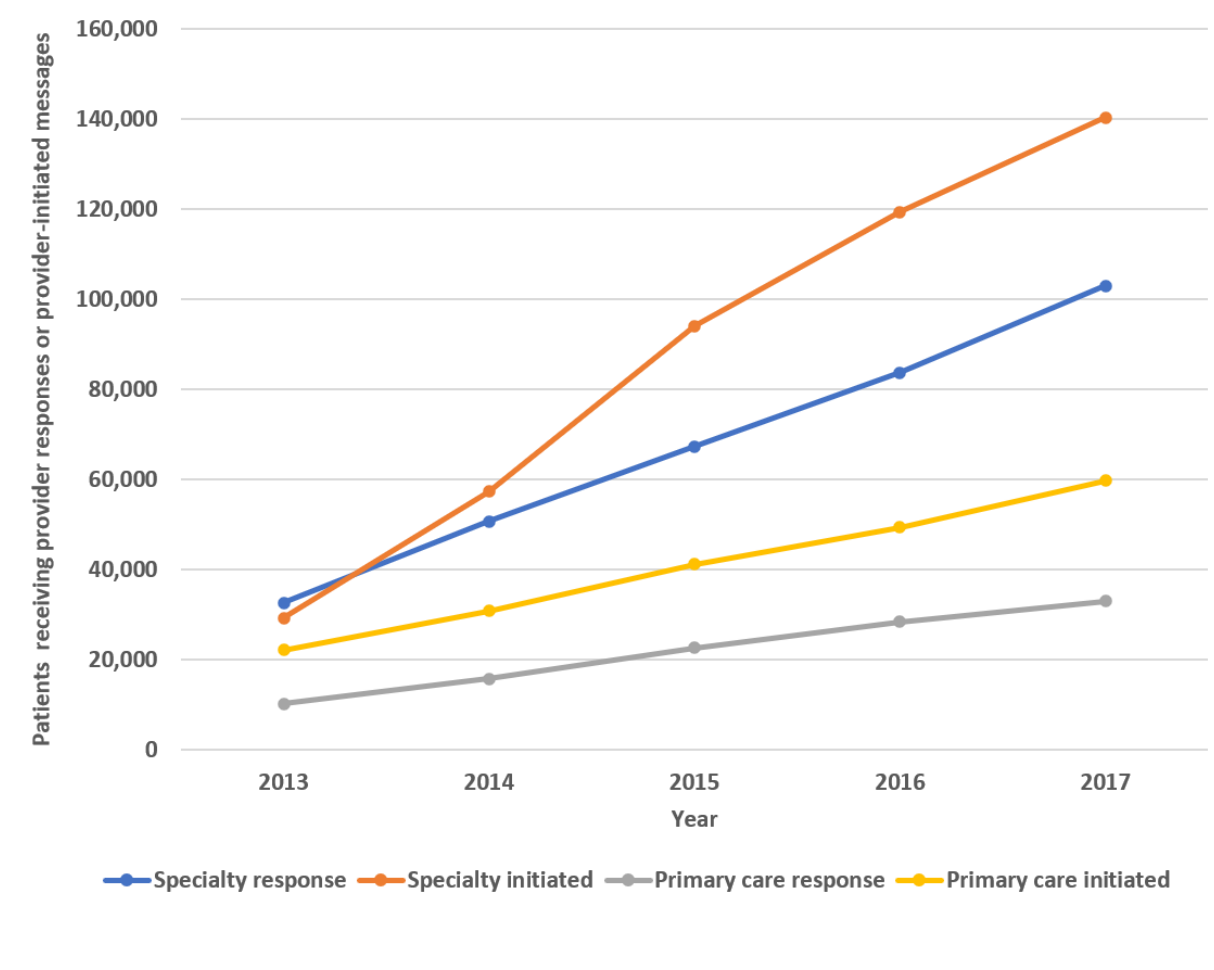
Figure 2. Distinct patients generating a provider response or provider-initiated message by